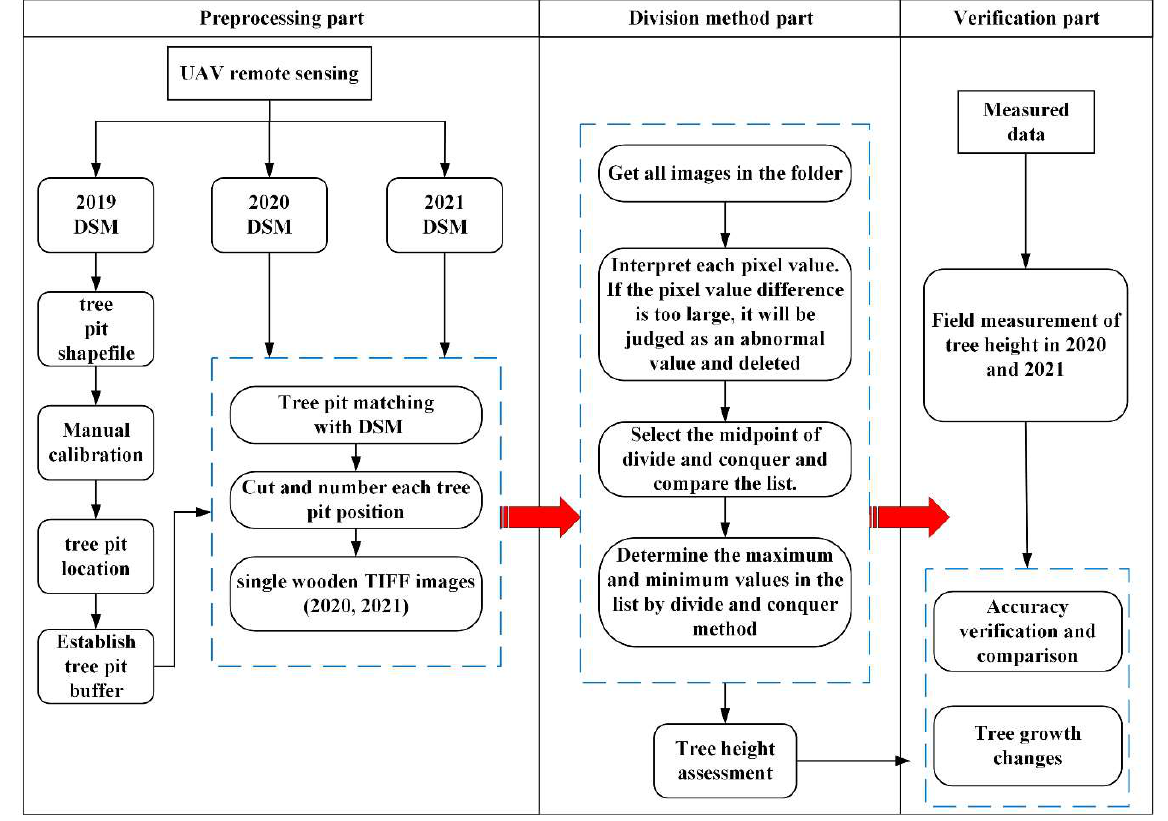
Figure 7. Tree height extraction process via divide-and-conquer algorithm.